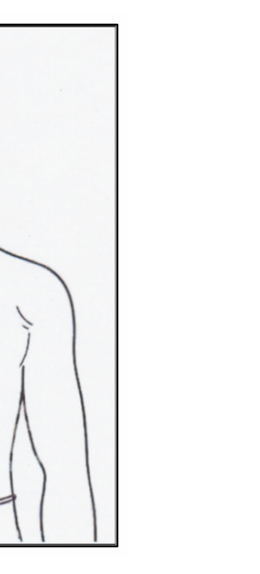
Figure 18. Schematic view of Triggerfish, wireless antenna and portable